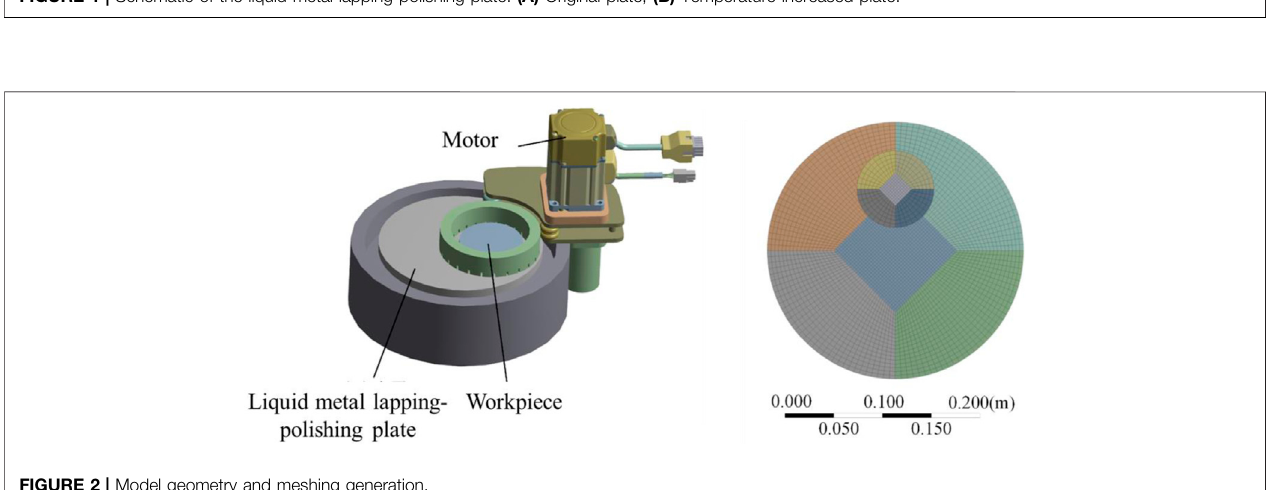
FIGURE 1 | Schematic of the liquid metal lapping-polishing plate. (A) Original plate, (B) Temperature increased plate.